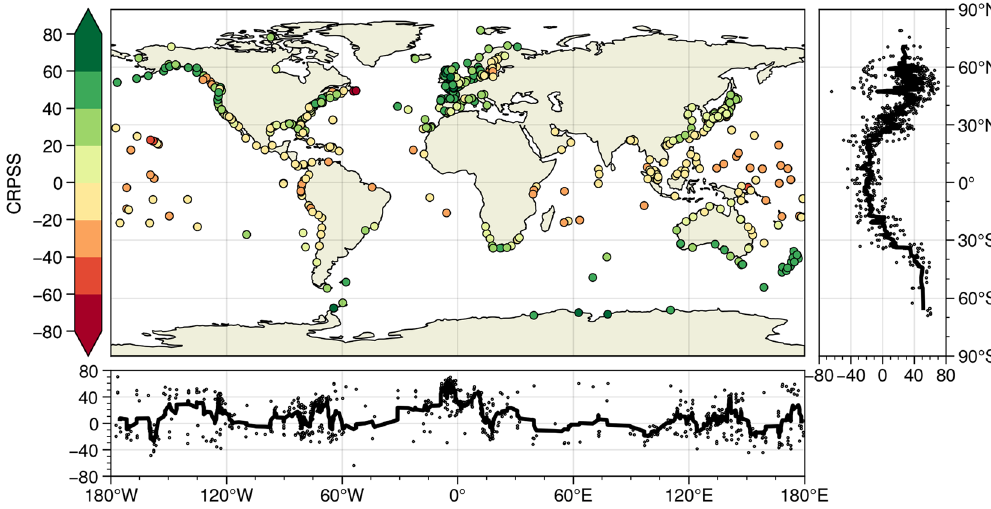
Figure 3. Highest CRPSS percentage obtained of all NN models per tide station. Meridional and zonal plots present the CRPSS values with a centred moving average of 10